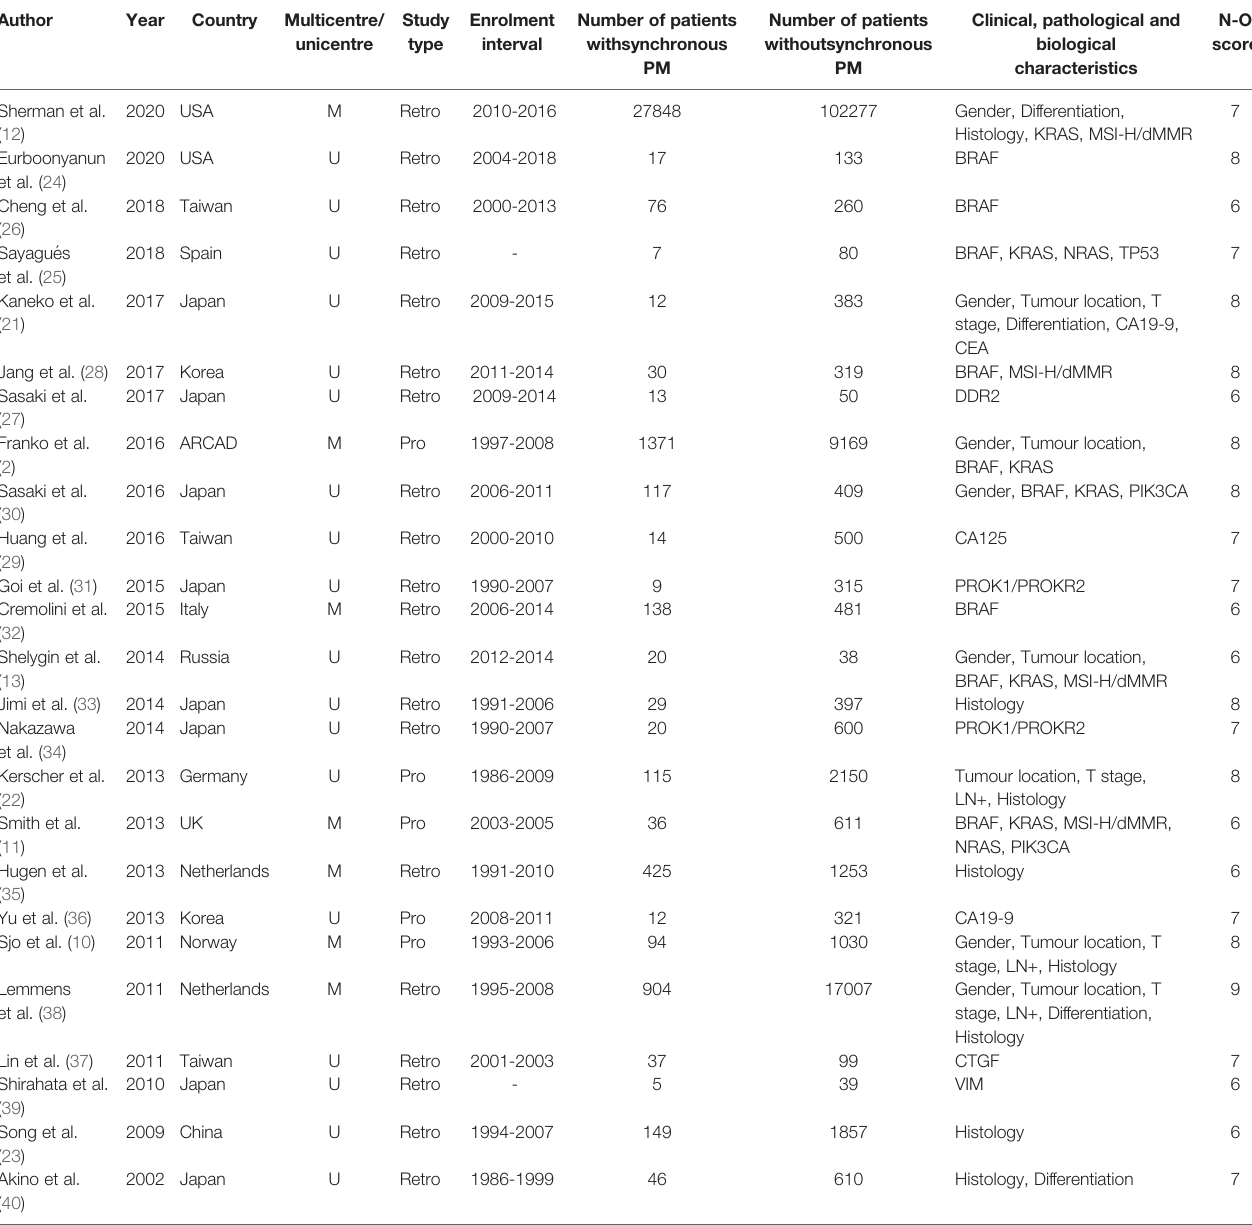
TABLE 1 | Characteristics of the included